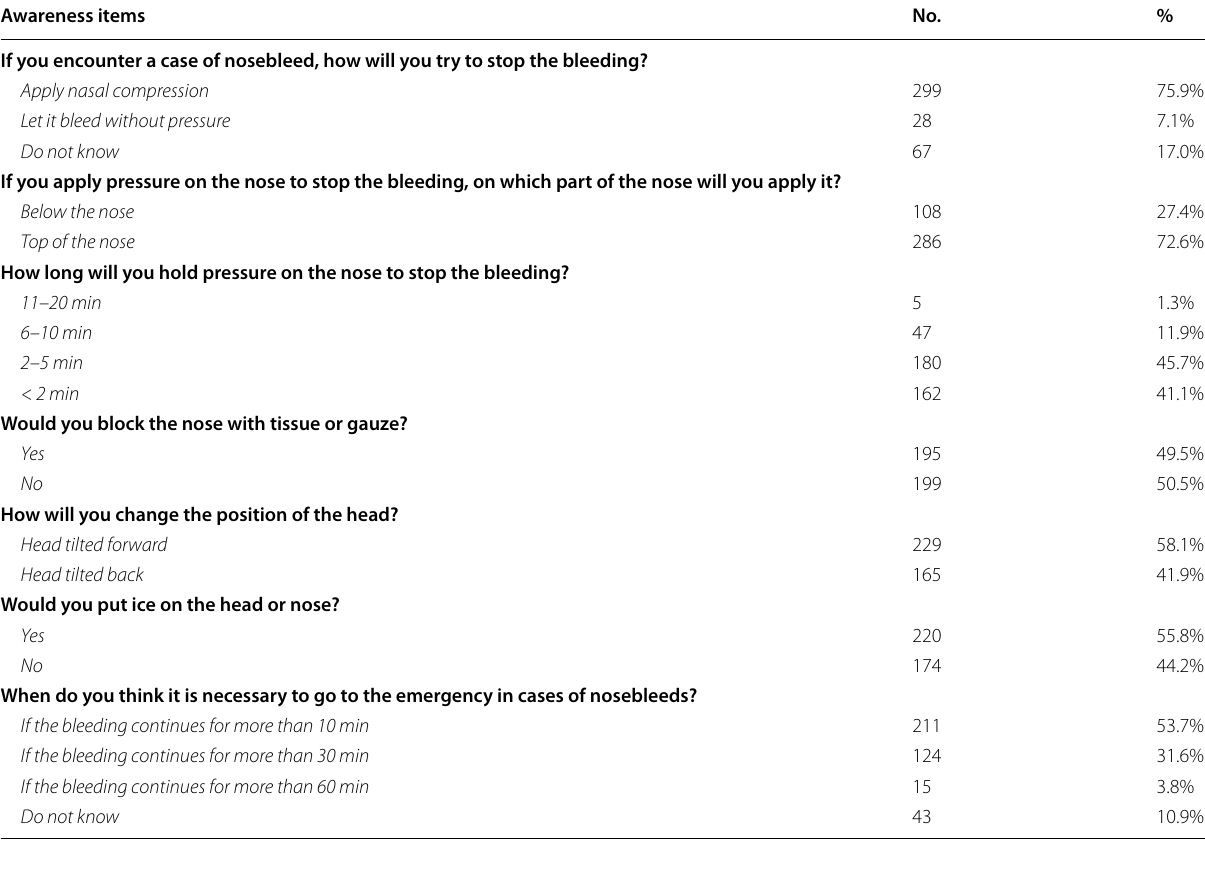
Table 2 Awareness regarding first aid management of epistaxis among school teachers in Aseer Region, Saudi Arabia Awareness items